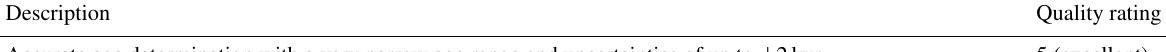
Table 9. Evaluation of the age information quality. Description Quality rating Accurate age determination with a very narrow age range and uncertainties of up to ± 2kyr. 5 (excellent) Narrow age range and uncertainties of ± 2–4kyr allowing the attribution to a specific substage of MIS 5. 4 (good) With uncertainties of ± 4–15kyr the RSL data point can be attributed only to a generic interglacial (e.g. MIS 5). 3 (average) Age determination using the alpha-counting technique results in large uncertainties with more than ± 15kyr. 2